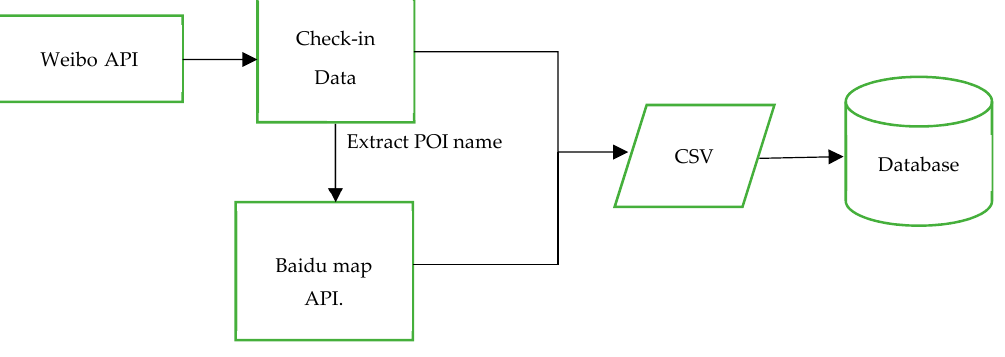
Figure 2. Frame for obtaining.